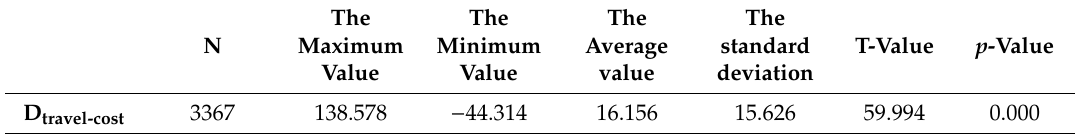
Table A4. The result of the paired-samples